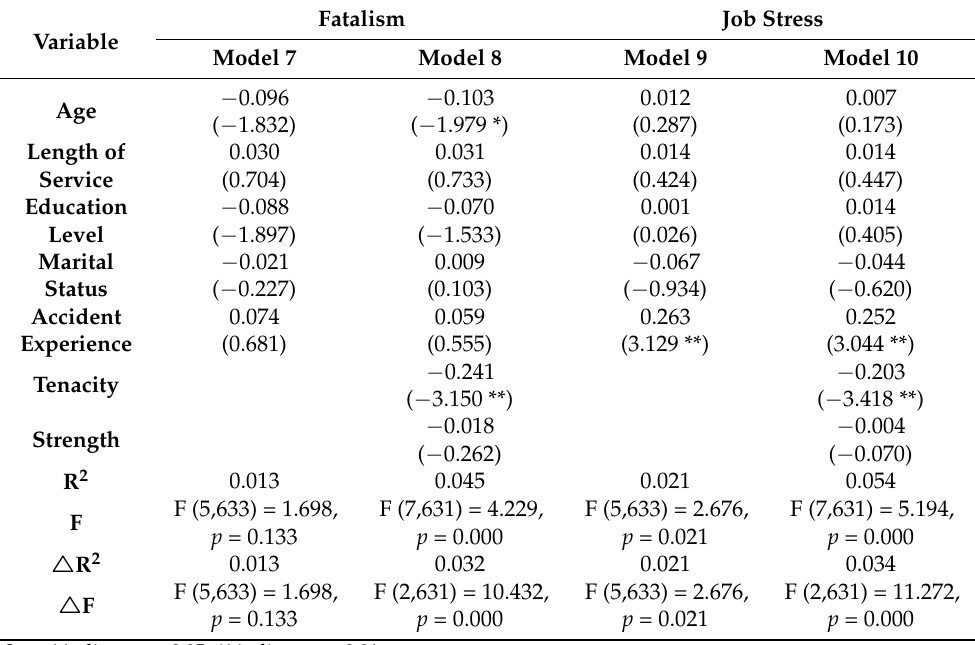
Table 13. Regression analysis of the two dimensions of resilience on fatalism and job stress (N = 639).